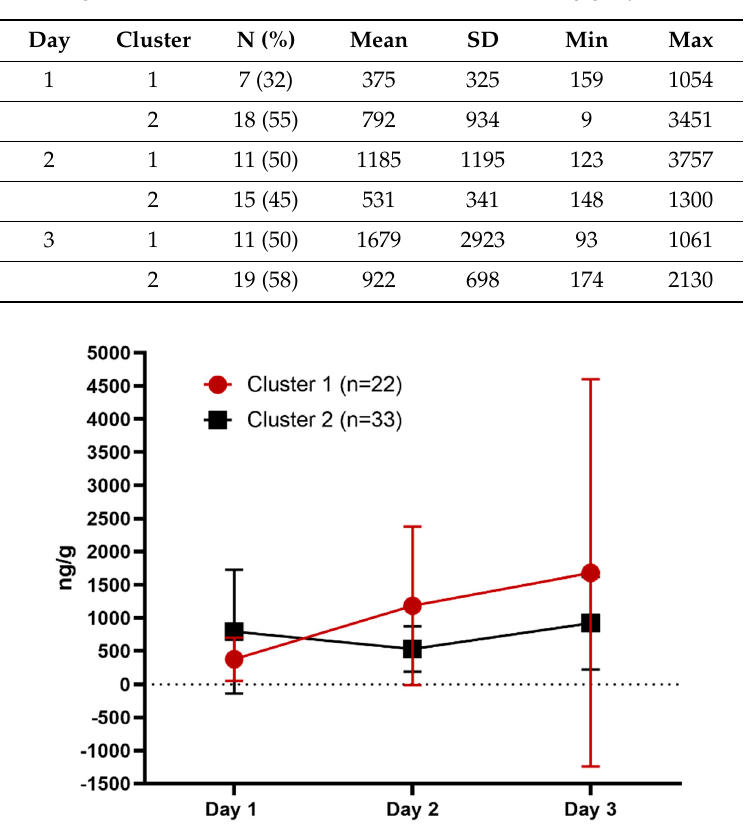
Table 3. Fecal glucocorticoid metabolite (FGM) concentration (ng / g) by cluster and day.